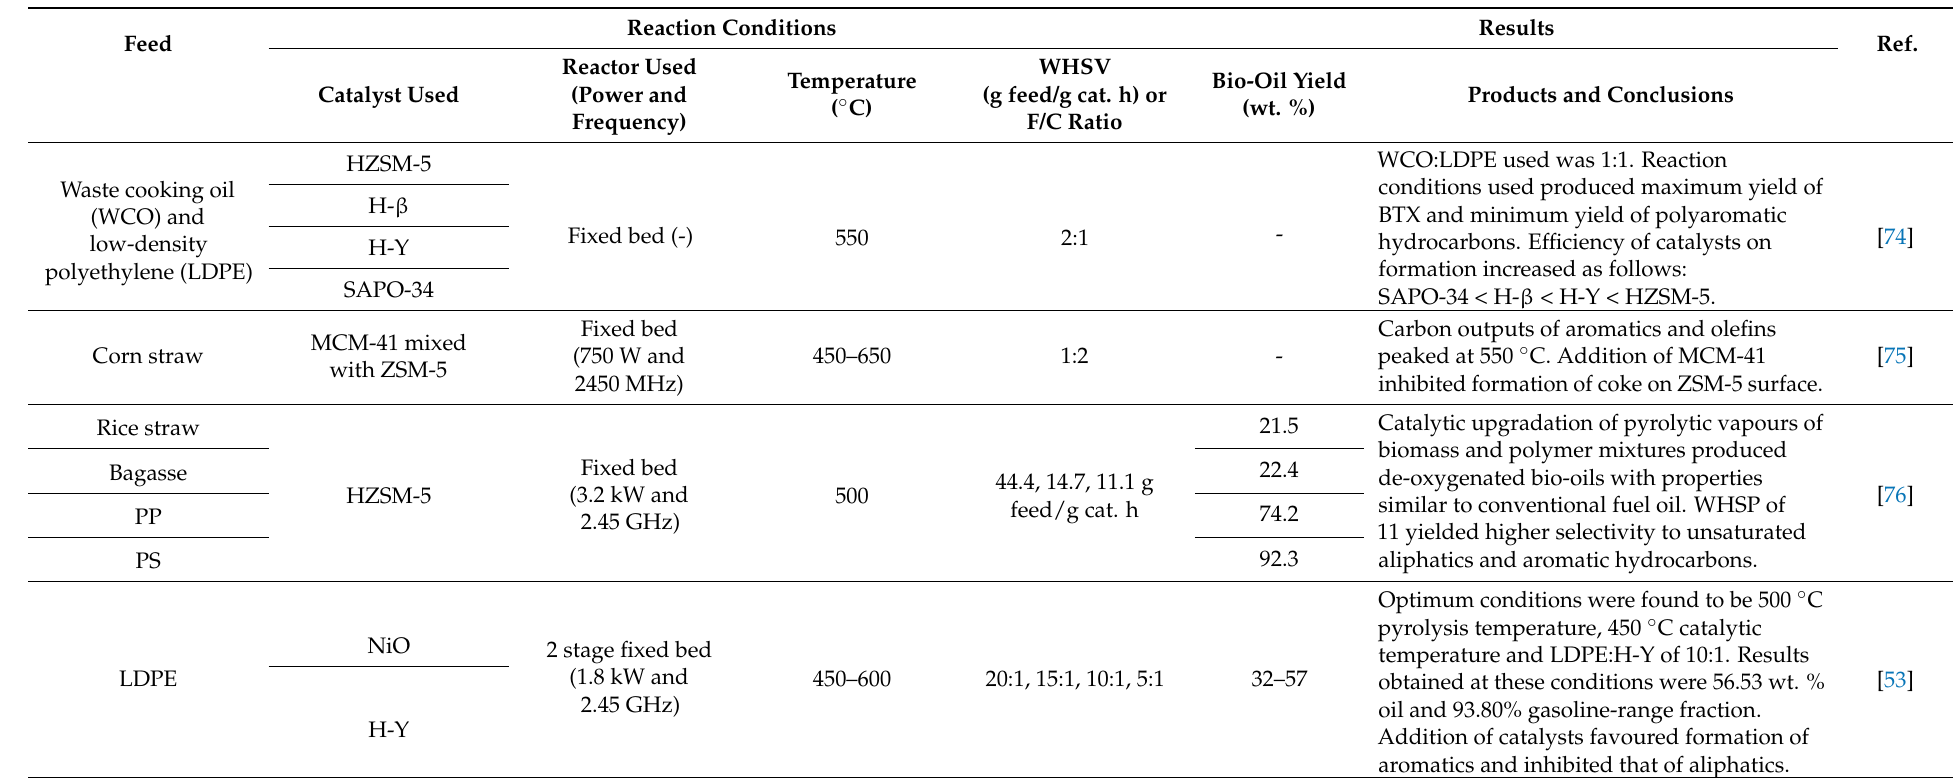
Table 6. Summary of recent works on catalytic MAP using zeolites as